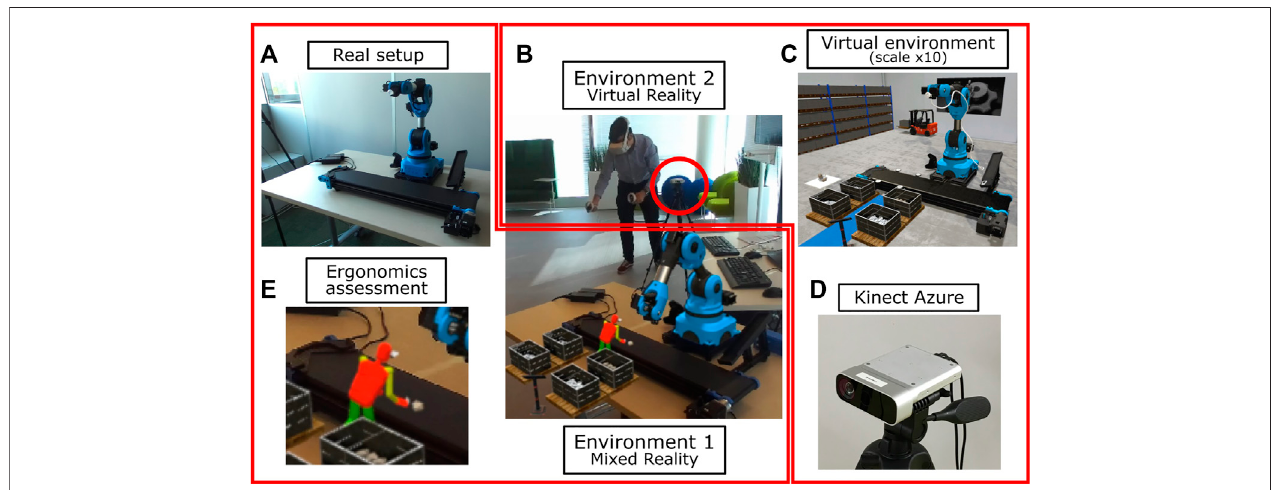
FIGURE15 | A demonstrator with multi-user environments involvingaNiryo Onerobot (A) . The fi rst environment is used toaccess robot data and for mixed reality display (B) .Thesecondenvironmentisusedforvirtualrealitysimulation insideascaledvirtualenvironment (C) .Bothenvironmentsshare thesame digitaltwinstate,with different representations and different scales. A Kinect Azure camera (D) and red circle) is used to evaluate the ergonomics posture of the operator (E) .